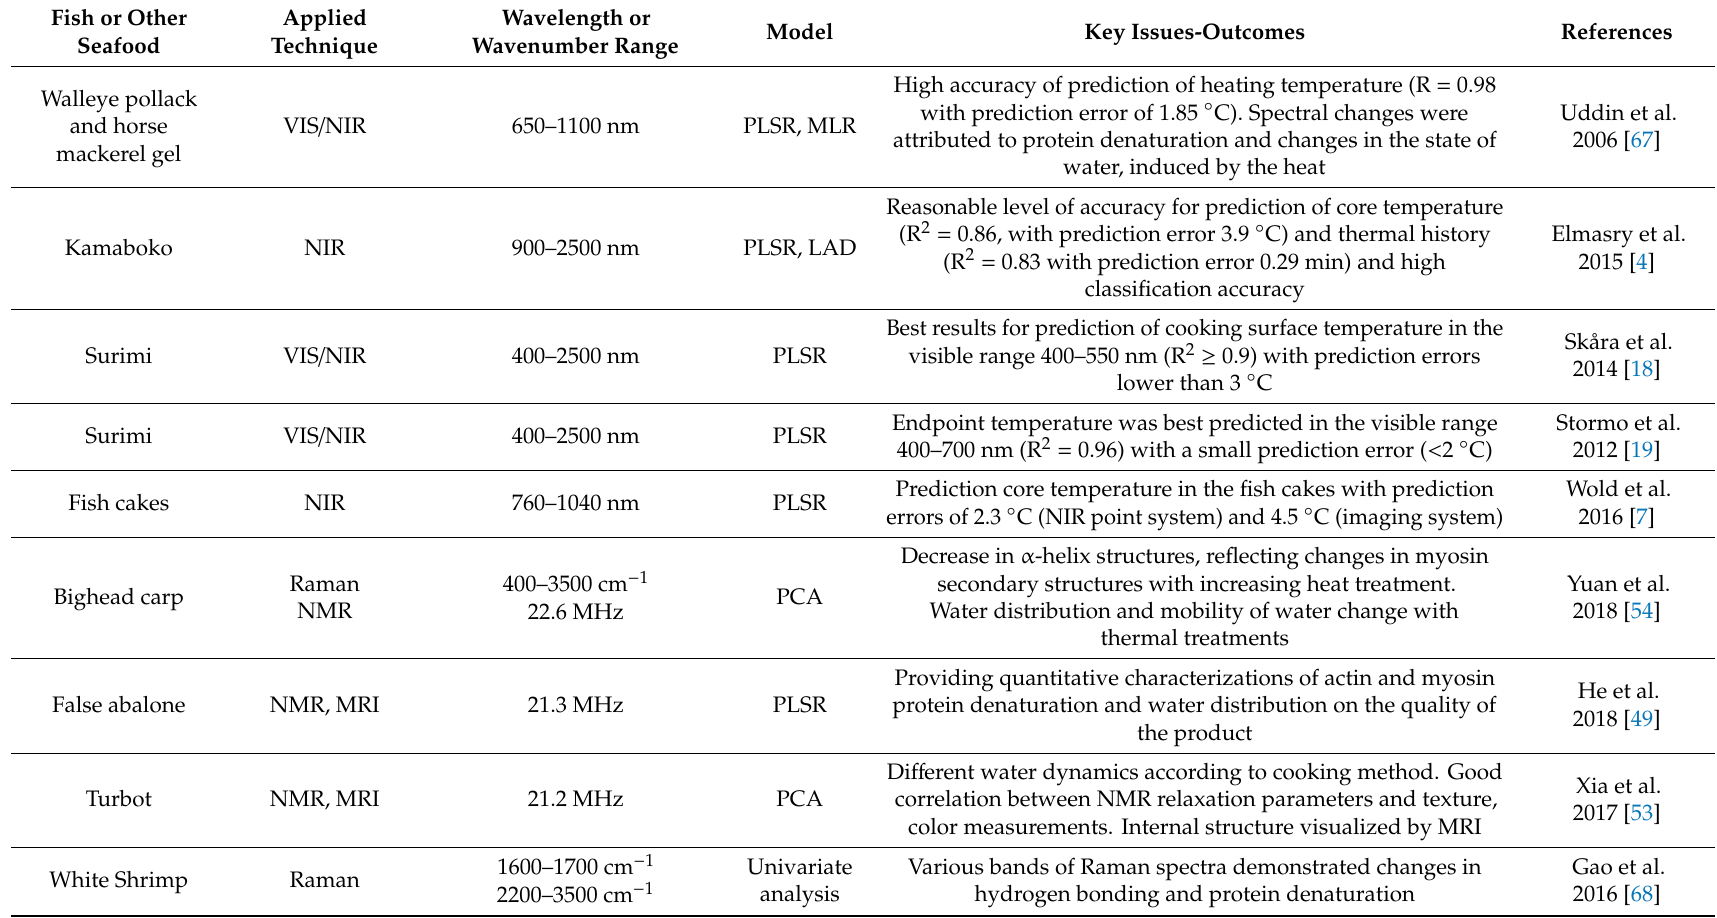
Table 2. Examples of applications of spectroscopic techniques for monitoring thermal treatments applied to fish and other